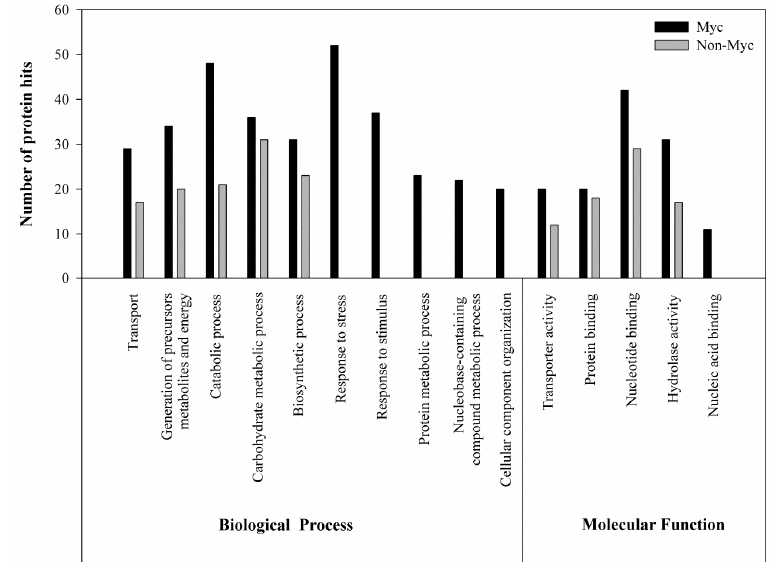
Figure 2. Gene ontology (GO) assignments of biological processes and molecular function for proteins homologous to plant proteins derived from label-free LC-MS/MS proteomics of mycorrhizal (Myc) and non-mycorrhizal (Non-Myc) roots of Oeceoclades maculata.